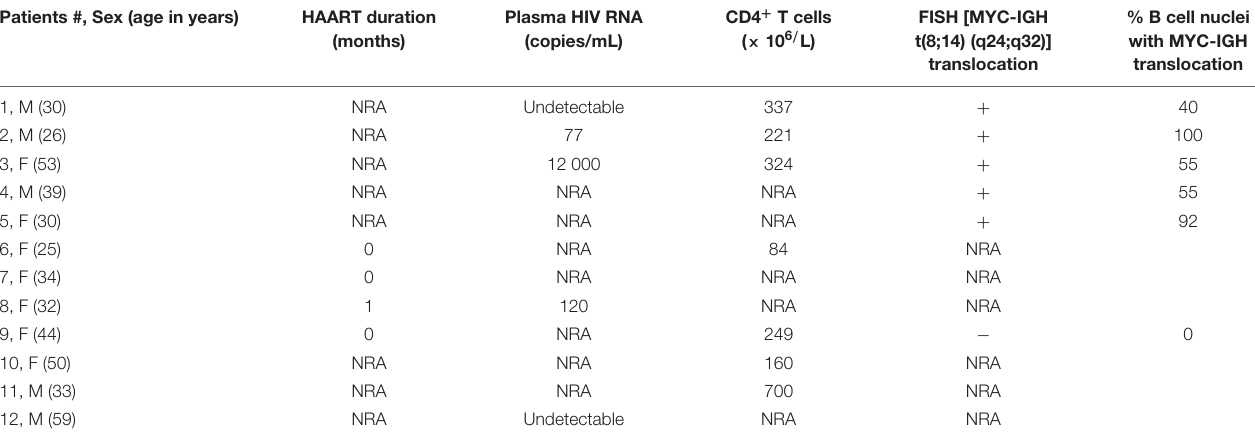
TABLE 1 | Clinical features of the HIV-BL cohort investigated in this study. Patients #, Sex (age in years) HAART duration